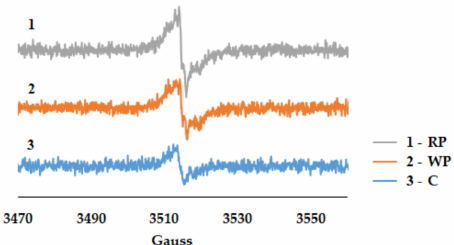
Figure 6. EPR spectra of the grape pomace (WP, RP) and canes (C) extracts treated with